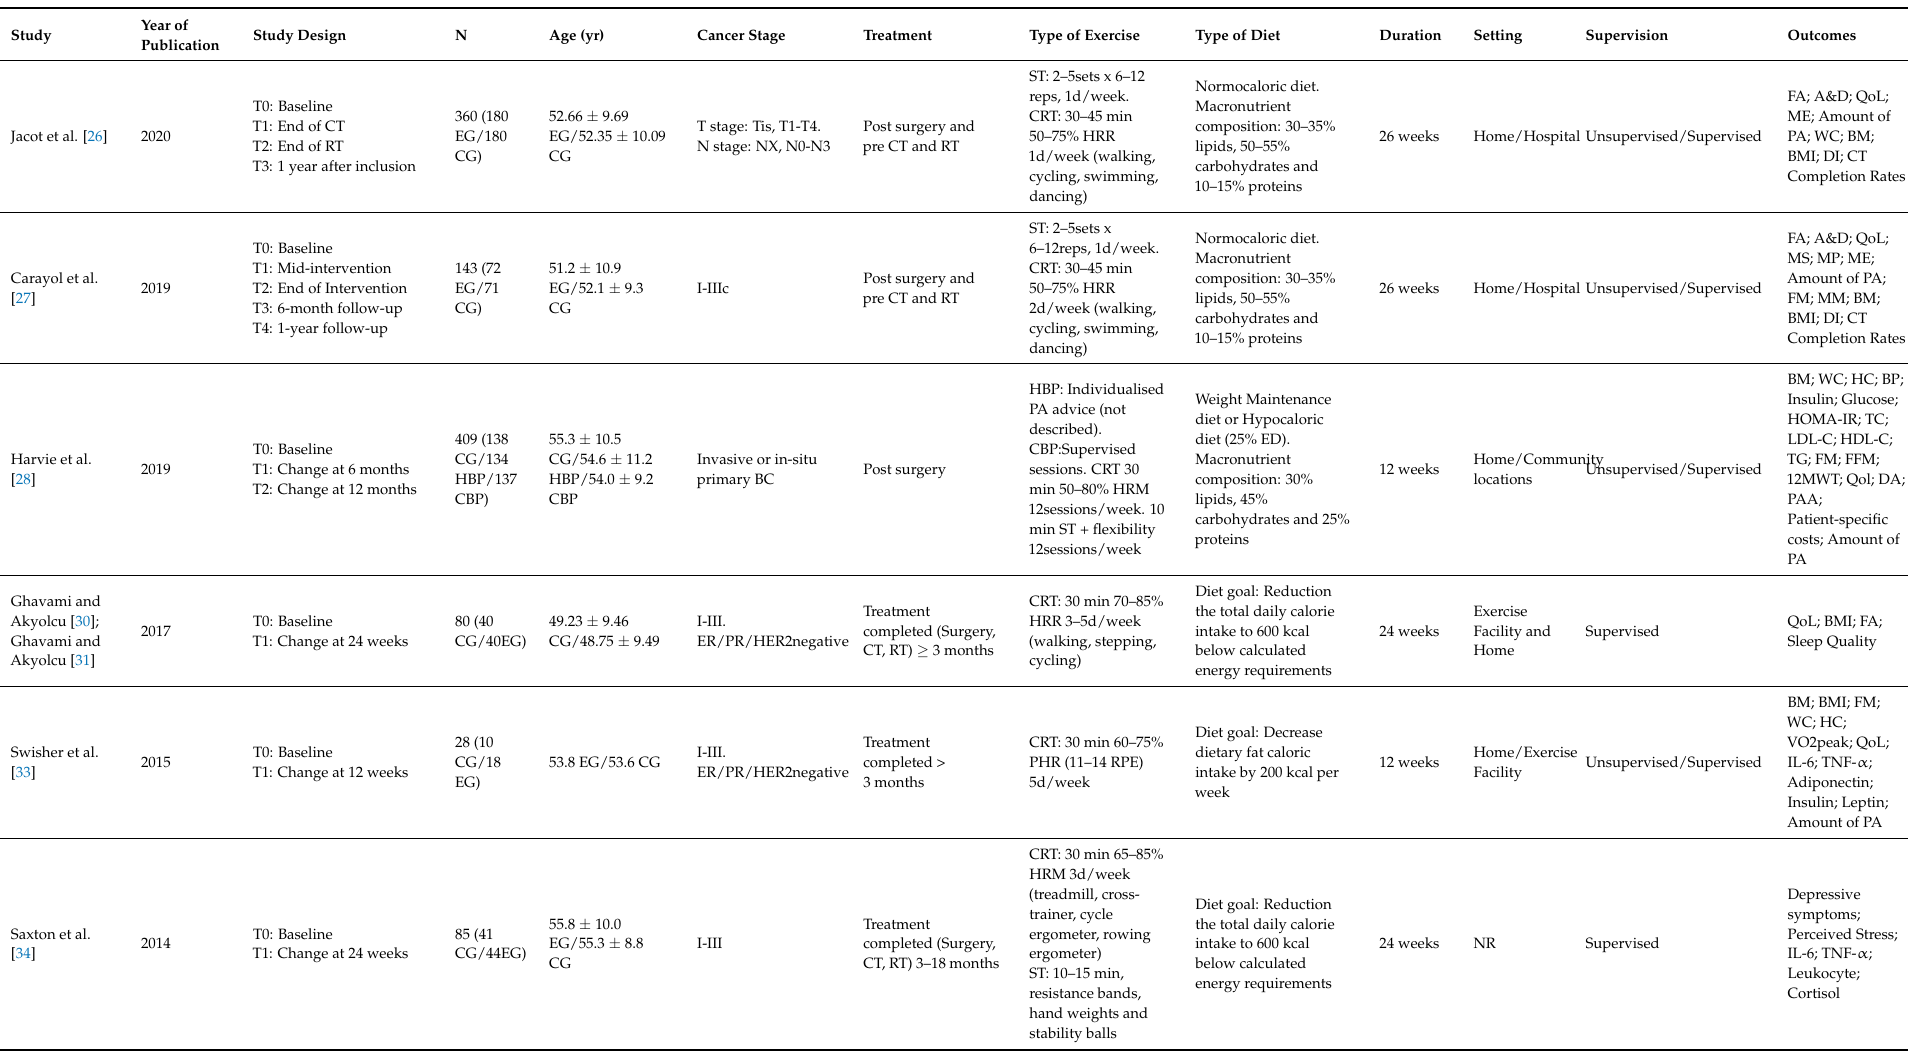
Table 1. Characteristics of studies with exercise plus diet